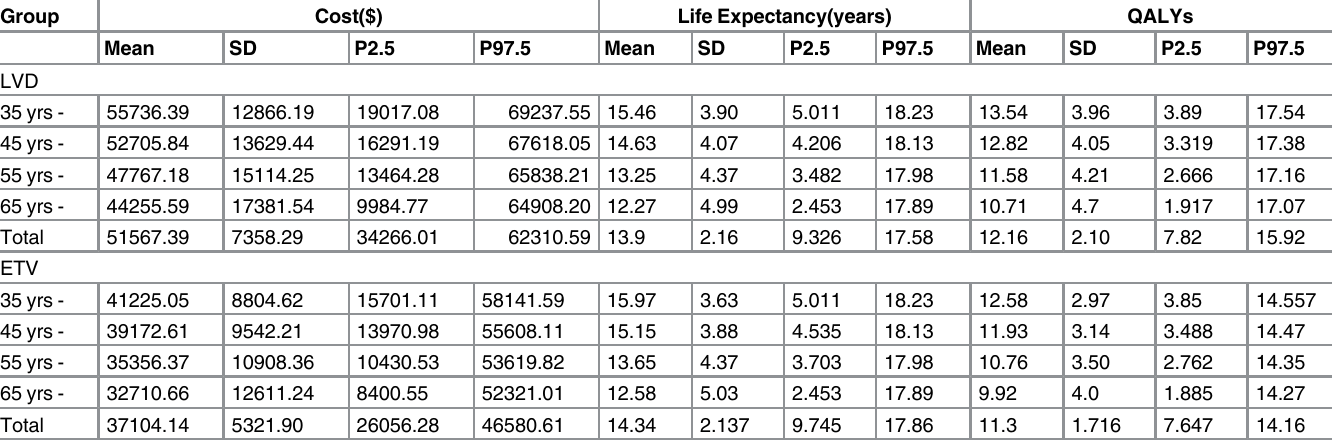
Table 5. Expected costs and benefits of antiviral treatment for patient subgroups calculated using Monte Carlo simulation. Group Cost($) Life Expectancy(years) QALYs Mean SD LVD 45 yrs